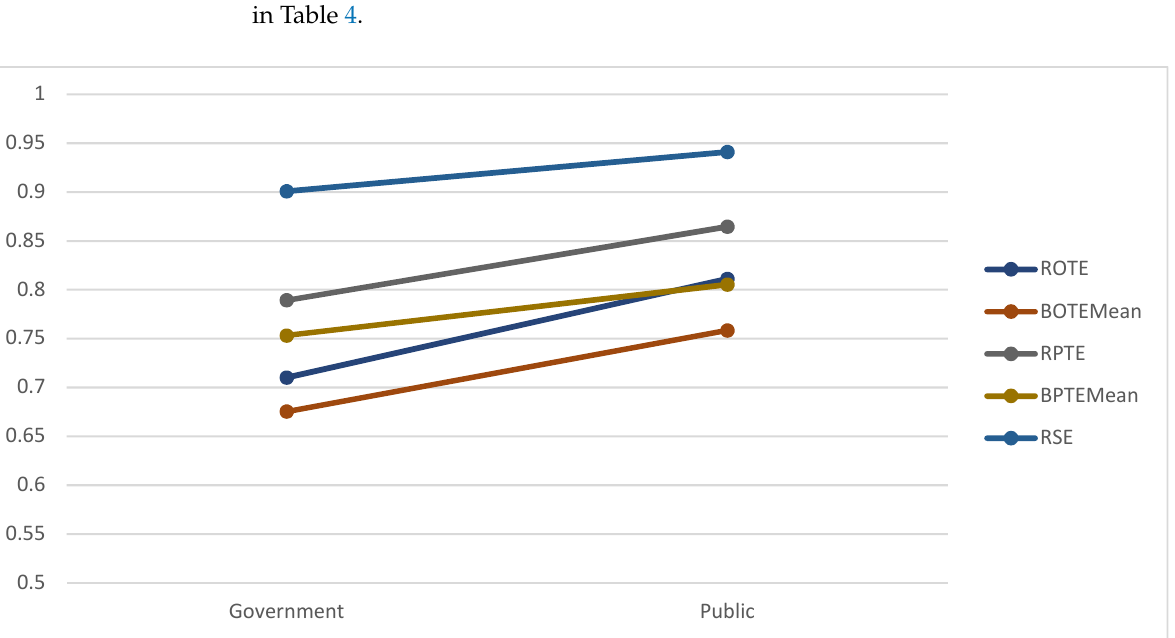
Figure 5. Efficiency scores of the power-generating companies per ownership type.